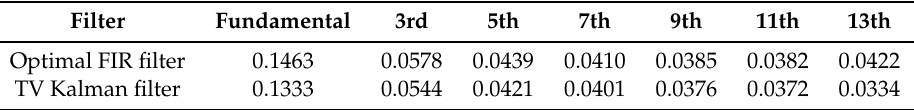
Figure 3. Estimated magnitude of third and 13th harmonic components. Table 1. The rms estimation errors ( × 10 − 3